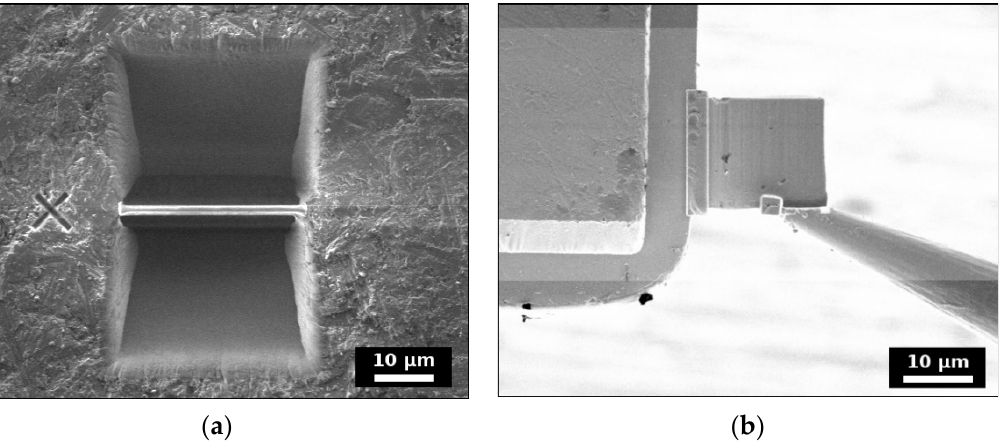
Figure 1. Preparation of FIB-lamellae, ( a ) wedge-shaped trenches dug out with the focused Ga ion-beam on both sides of the sample material covered with a protective Pt layer, ( b ) attachment of lamella to the sample holder (Figures taken from [56]).